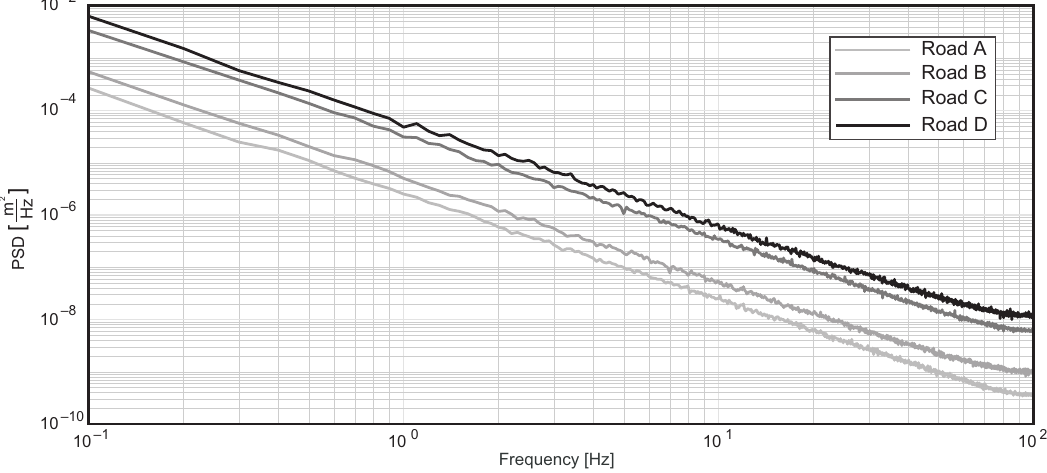
Figure 6. PSDs of the four road profiles.